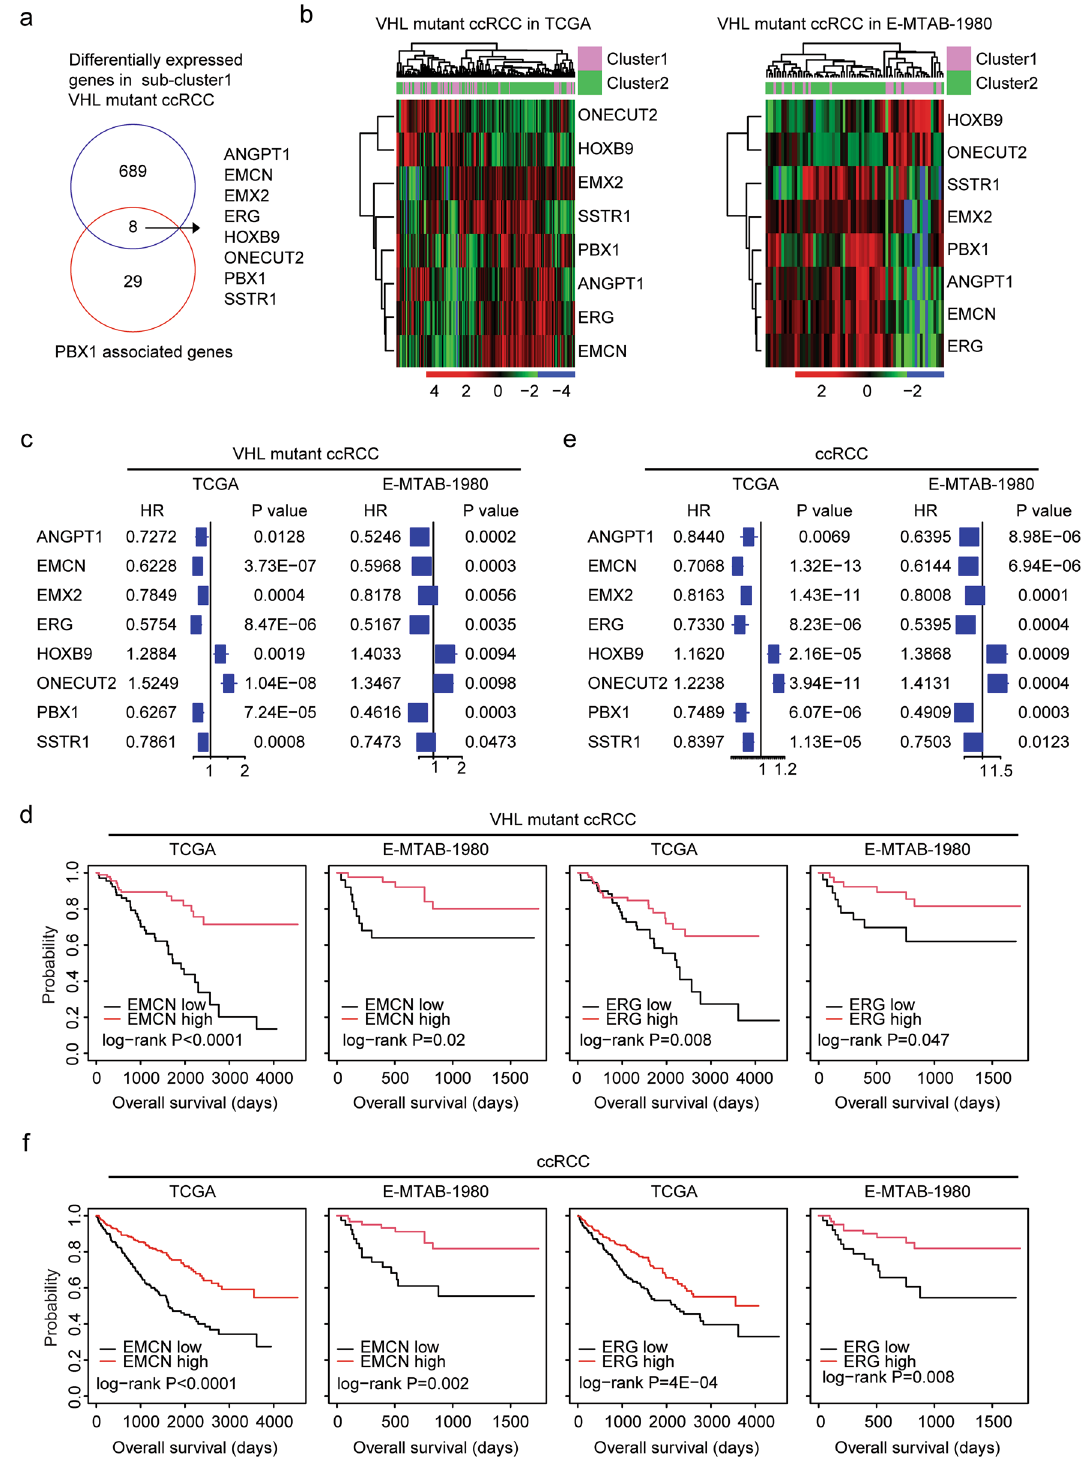
Figure 4. EMCN and ERG are associated with the classification and prognosis of VHL mutant ccRCC. ( a ) Eight PBX1 associated genes were differentially expressed in sub-cluster1 VHL mutant ccRCC patients in TCGA and E-MTAB-1980 datasets. ( b ) Un-supervised clustering heatmaps demonstrated the expression levels of PBX1 associated genes in VHL mutant ccRCC patients in TCGA and E-MTAB-1980 datasets. ( c ) Forest plots showed the prognosis of PBX1 associated genes in the predication of the clinical overall survival of VHL mutant ccRCC in TCGA and E-MTAB-1980 datasets. Hazard ratio (HR) and P values were determined by univariate cox regression assay. ( d ) Kaplan–Meier Plotters showed the prognostic effects of EMCN and ERG in VHL mutant ccRCC patients in TCGA and E-MTAB-1980 datasets. ( e ) The prognosis of PBX1 associated genes in the predication of the clinical overall survival of ccRCC in TCGA and E-MTAB-1980 datasets. ( f ) The prognostic effects of EMCN and ERG in ccRCC patients in TCGA and E-MTAB-1980